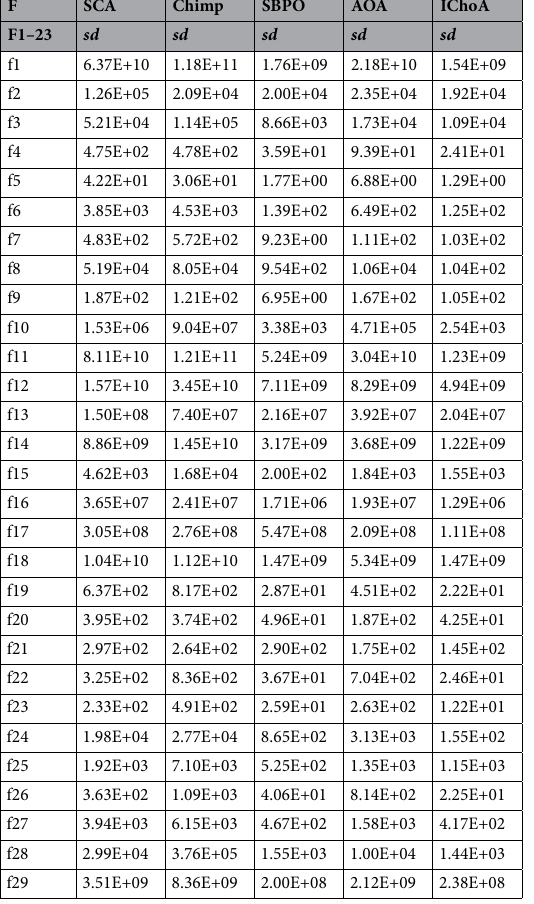
Table 4. Statistical best ( sd ) solutions of algorithms on the 29-CEC’2017 standard test